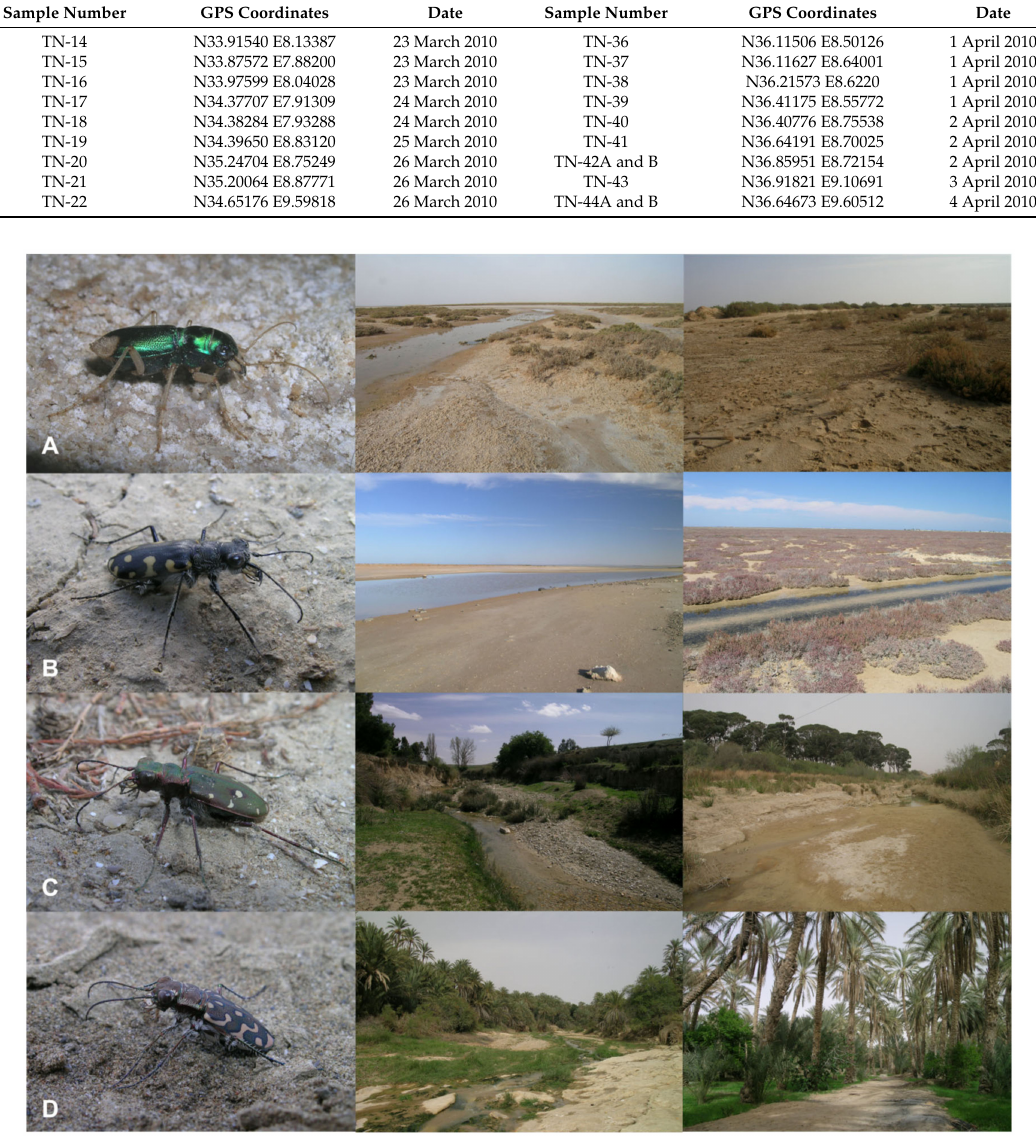
Figure 1. Pictures of the studied tiger beetle species and sample macrohabitats occupied by these species in Tunisia. ( A ) Grammognatha euphratica euphratica , ( B ) Calomera lunulata , ( C ) Cicindela campestris atlantis , and ( D ) Lophyra flexuosa flexuosa (photo by R.